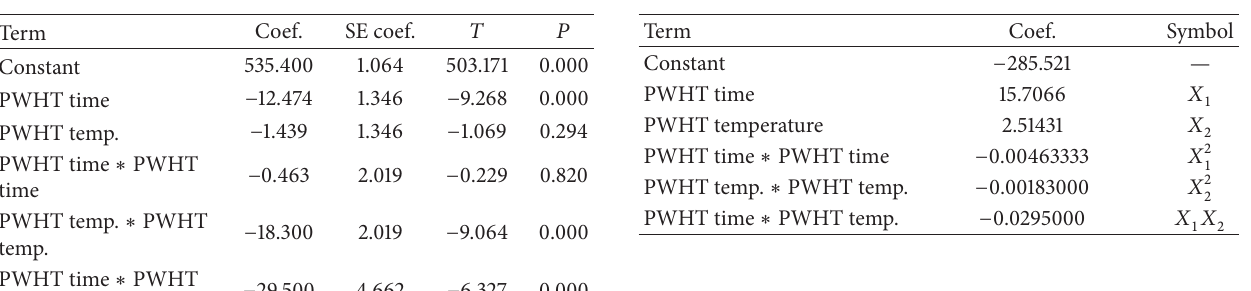
Table 7: Estimated regression coefficients for tensile strength